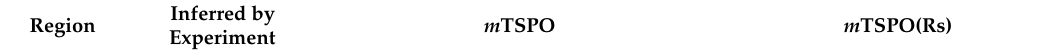
Table 1. Residues of mouse TSPO located at the dimer interface identified experimentally [19] (left), predicted by m TSPO (center) and m TSPO(Rs) structures at the end of the dynamics. Region